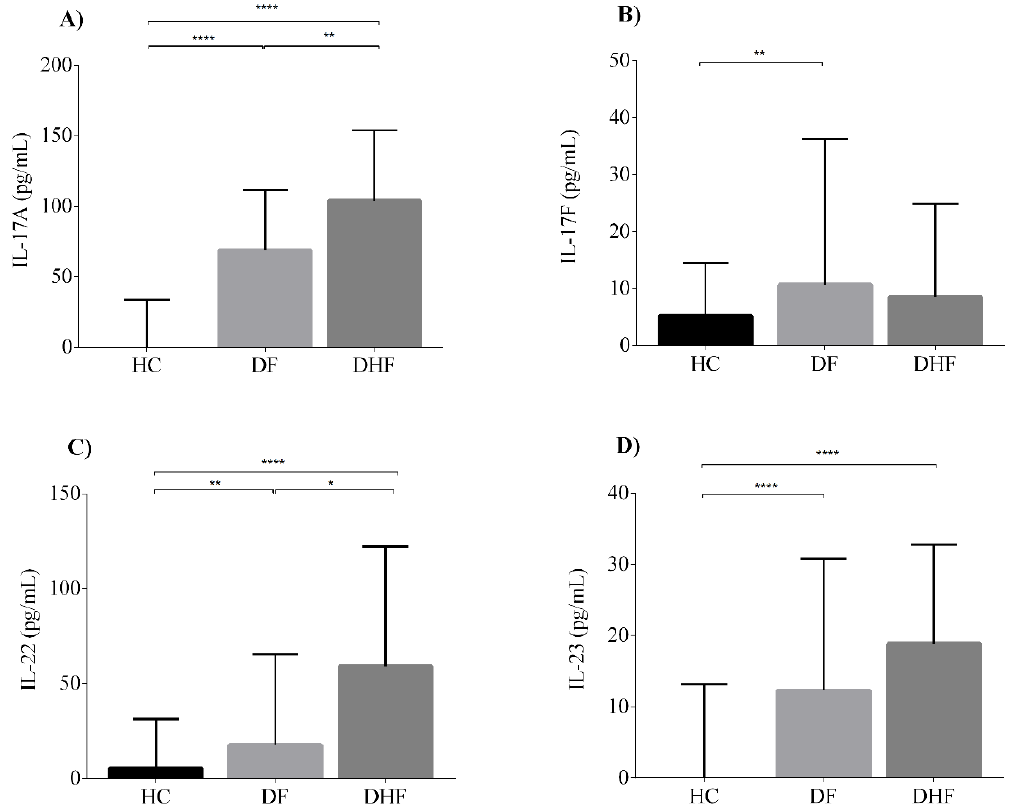
Figure 3. IL-17A and IL-22 are associated with DHF severity. Serum levels of ( A ) IL-17A, ( B ) IL-17F, ( C ) IL-22 and ( D ) IL-23 in healthy controls (HC) ( n = 78) compared with dengue fever (DF, n = 97) and dengue hemorrhagic fever (DHF, n = 31). Individual data are shown and the horizontal line is the median value. Statistical difference is based on the Kruskal–Wallis with Dunn’s multiple comparison post-tests. * p < 0.05 ** p < 0.01, **** p < 0.0001.